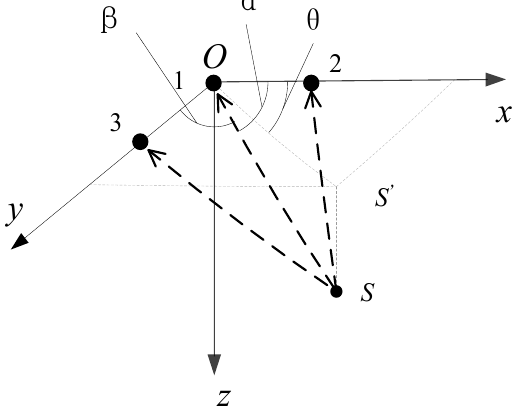
Figure 4. The principle of positioning.